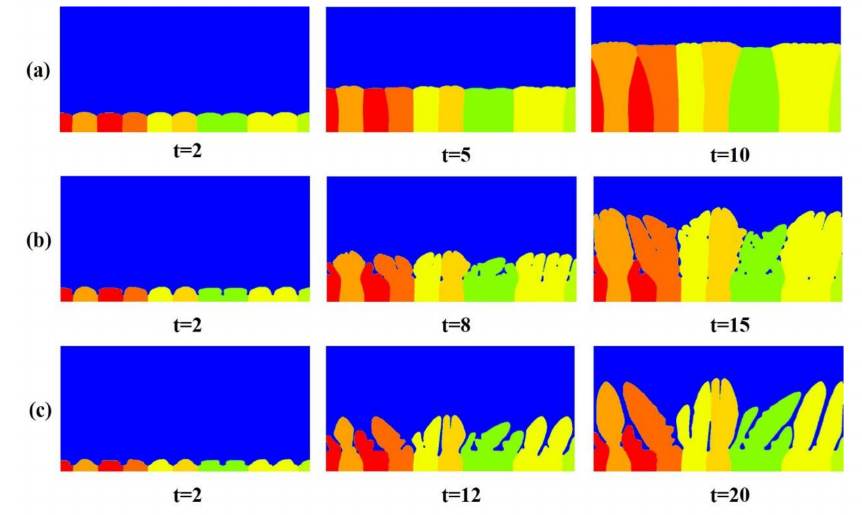
Figure 8. Competitive growth of columnar grains at di ff erent solidification rates: the temperature of bottom surface is ( a ) 1800 K, ( b ) 2000 K, ( c ) 2100